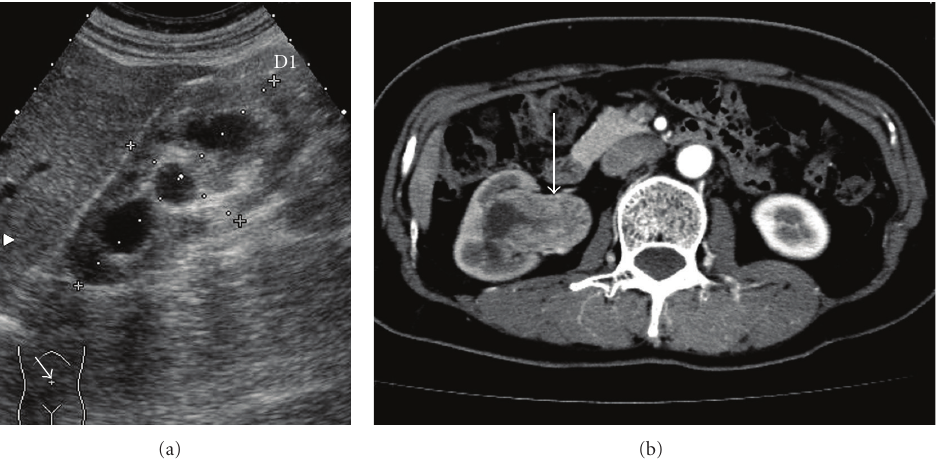
Figure 1: (a) Abdominal echography, showing right-sided unilateral hydronephrosis. (b) Abdominal computed tomography with contrast, showing an enhanced mass in the right renal pelvis (arrow) in association with pelvic dilatation and slight thinning of renal cortex.